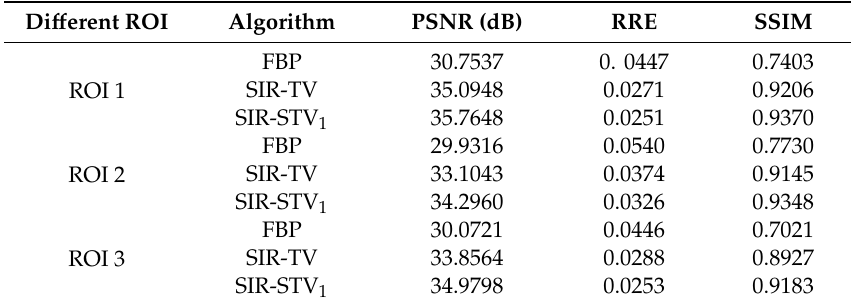
Table 2. A summary of the evaluation indexes of the reconstructed image at different noise levels in the Thorax image simulated studies.